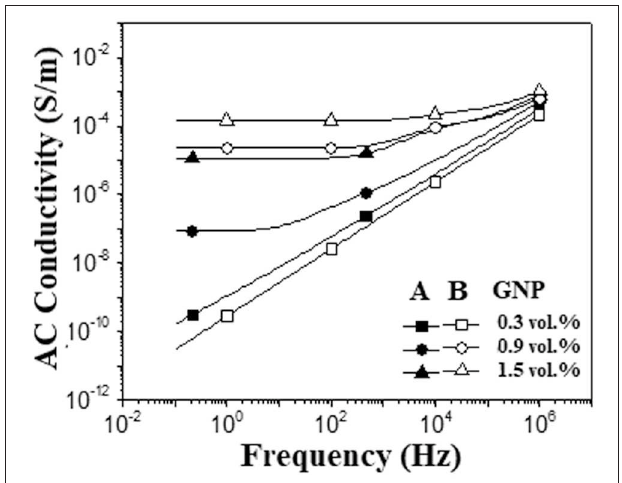
FIGURE 1 | AC electrical conductivity vs. frequency for ER/GNP composites as a function of the dispersion procedure and GNP content (A, method A; B, method